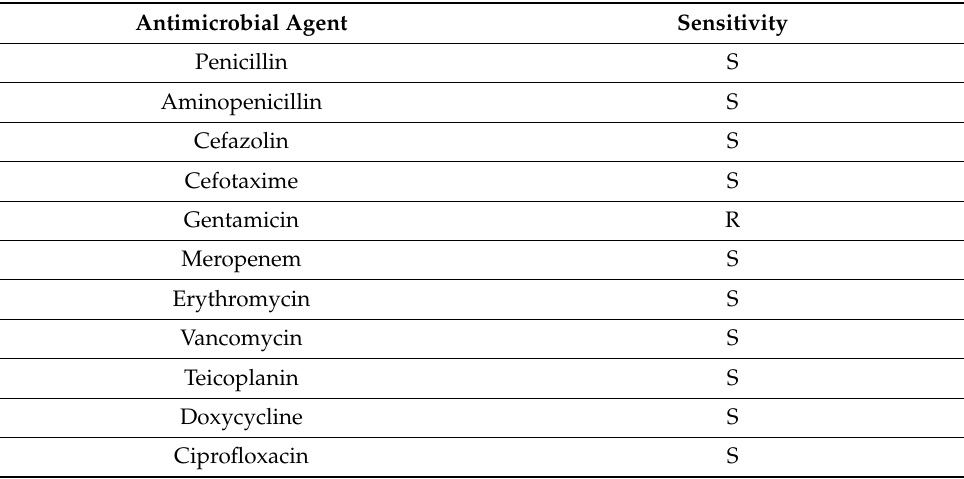
Table 2. Antibiotic susceptibility of Gemella sanguinis in our case.